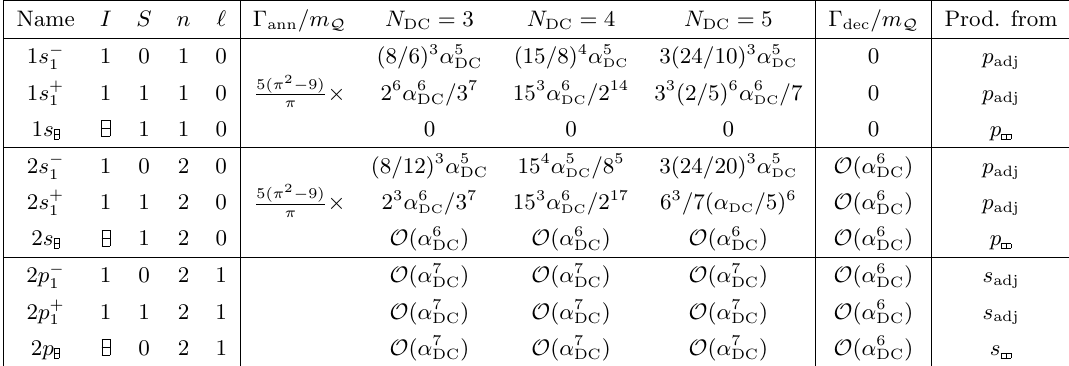
Table 4 . Summary of perturbative di-quark bound states in SU( N )